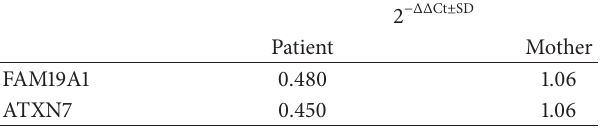
Table 1: Validation with quantitative reverse-transcription poly- merasechainreaction(qRT-PCR)assays.Thistableshowsthevalues obtained by means of qRT-PCR in the patient analyzed and her mother. Two amplicons were amplified by qRT-PCR; they were located in the deleted region (3p14.2-p14.1), in the FAM19A1 and ATXN7 genes. The control gene used to normalize the data was RPP30 , located at 10q23.31. The 2 −ΔΔ Ct ± SD values of the patient were less than half the values of her mother, who was used as the normal control. 2 −ΔΔ Ct ± SD Patient Mother FAM19A1 0.480 1.06 ATXN7 0.450